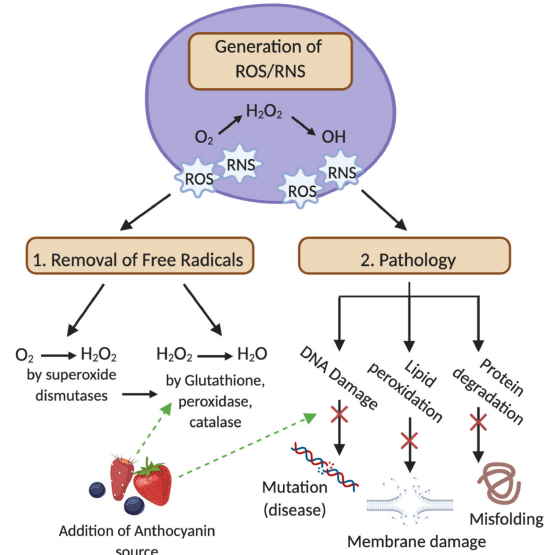
Figure 2. A proposed pathway facilitating the removal of ROS / RNS by internal antioxidant systems with ACN support. ROS / RNS production is a natural process occurring in most aerobic cells. Increased production is therefore related to injurious stimuli. Internal antioxidant systems are present to facilitate the removal of normal ROS / RNS production (pictured at point 1); however, inadequate removal or excessive production can result in cellular pathology such as lipid, protein and DNA damage (pictured at point 2). Anthocyanins can support this facilitated removal through their additional antioxidant properties, preventing further pathological